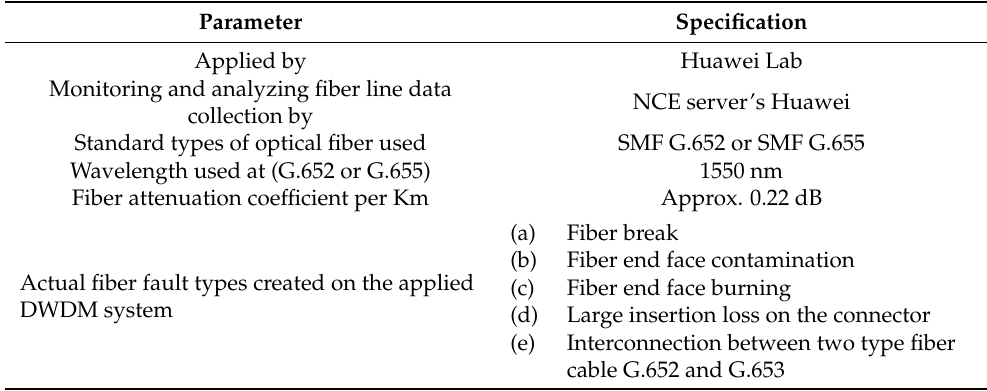
Table 5. The specifications of the implemented system for monitoring and analyzing the fiber line and collecting the practical results.